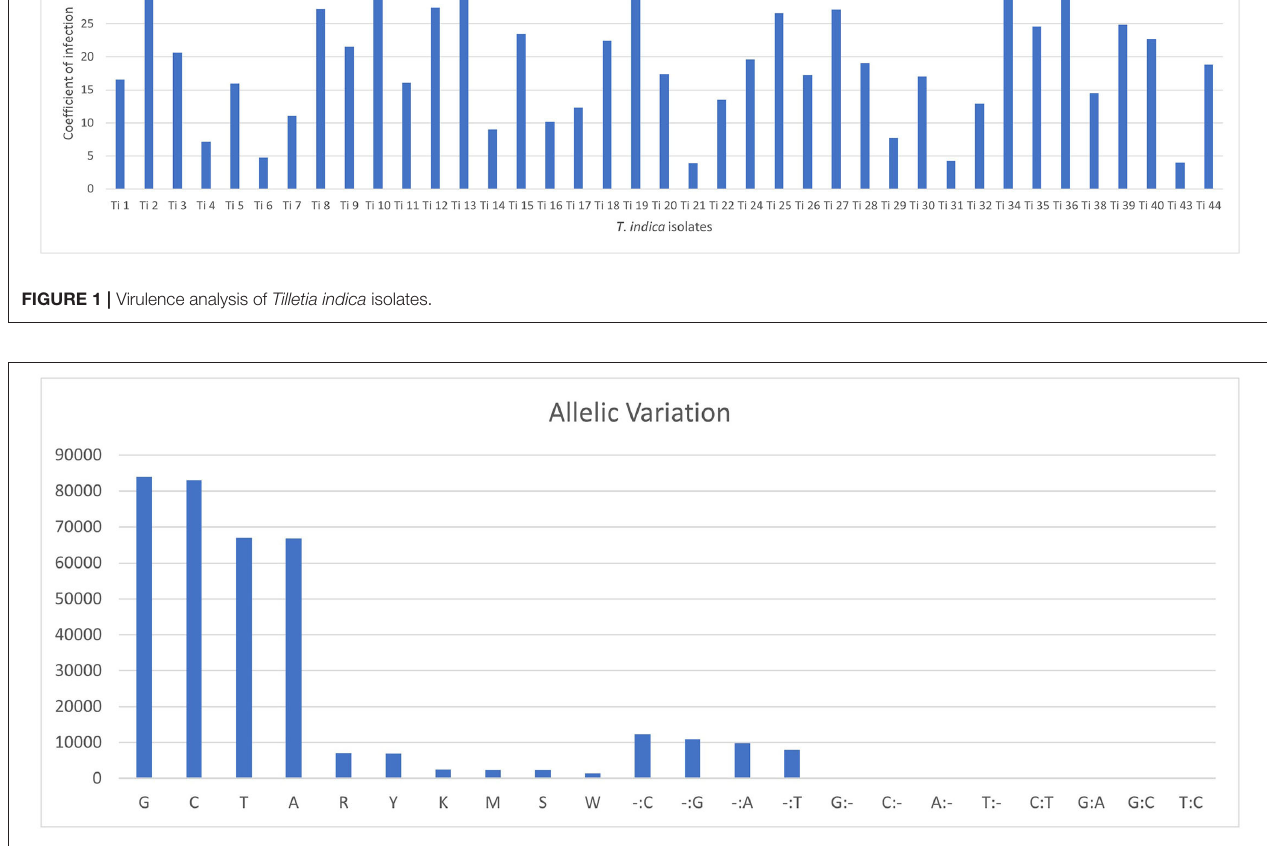
FIGURE 2 | Allelic variations frequency in T. indica isolates. Axis-x shows the nucleotide bases and axis-y represents the frequency of each nucleotide.